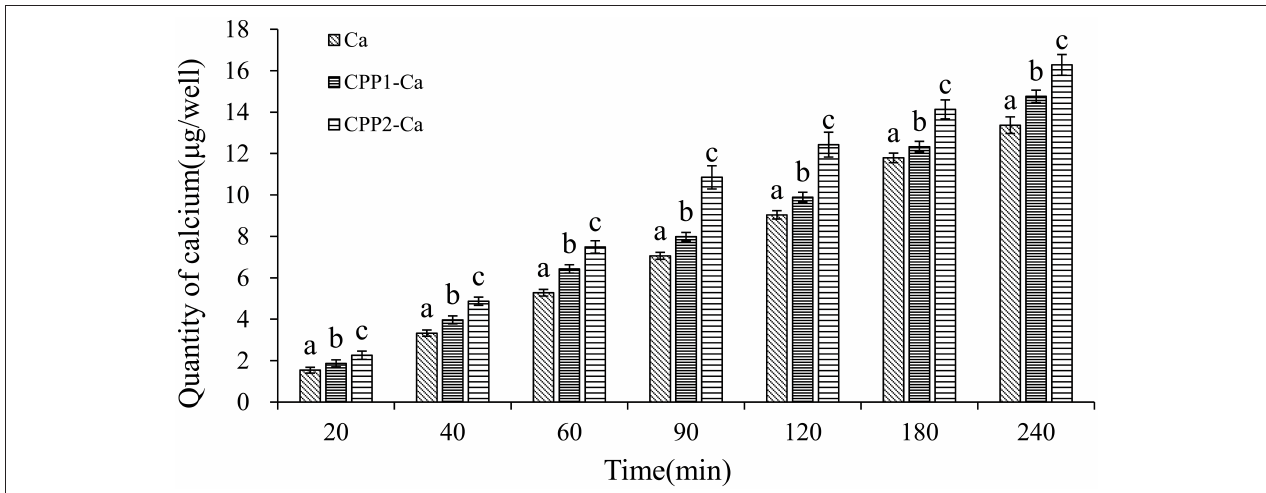
Frontiers in Nutrition |